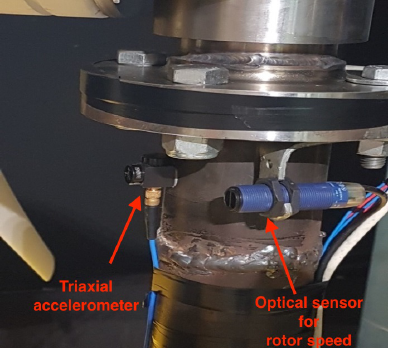
Figure 2. The layout of the sensor